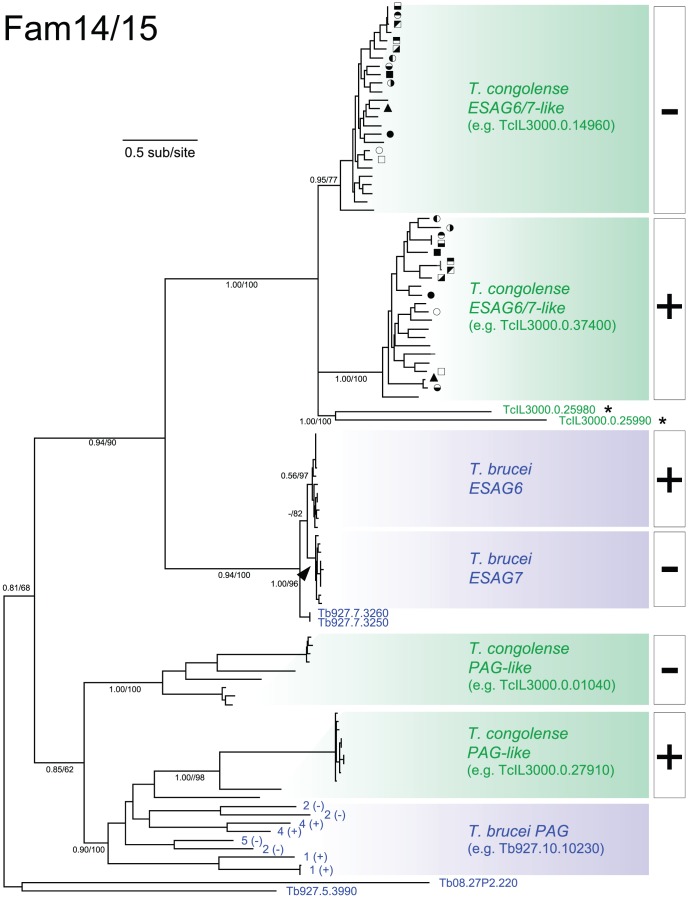
Bayesian phylogeny of transferrin receptor-like genes in T. brucei and T. congolense (Fam14/15).The phylogeny was estimated from an amino acid sequence alignment of 342 characters including all ESAG6-like proteins from T. brucei 927 (light blue) and T. congolense IL3000 (green), as well as ESAG6/7 sensu stricto from T. brucei 927, 427 and T. b. gambiense 972 (dark blue). A mixed amino acid substitution strategy was applied with default settings using MrBayes v3.2.1. The phylogeny is rooted using an outgroup of two a-type VSG protein sequences from T. brucei. Bayesian posterior probability/non-parametric bootstrap values are provided for selected nodes. Terminal nodes that describe sequences derived from tandem pairs in T. congolense are labeled with common symbols. Terminal nodes representing Procyclin-Associated Genes (PAG1, 2, 4 and 5) are numbered. Throughout, the presence or absence of predicted GPI anchor signals is noted using + and − respectively.